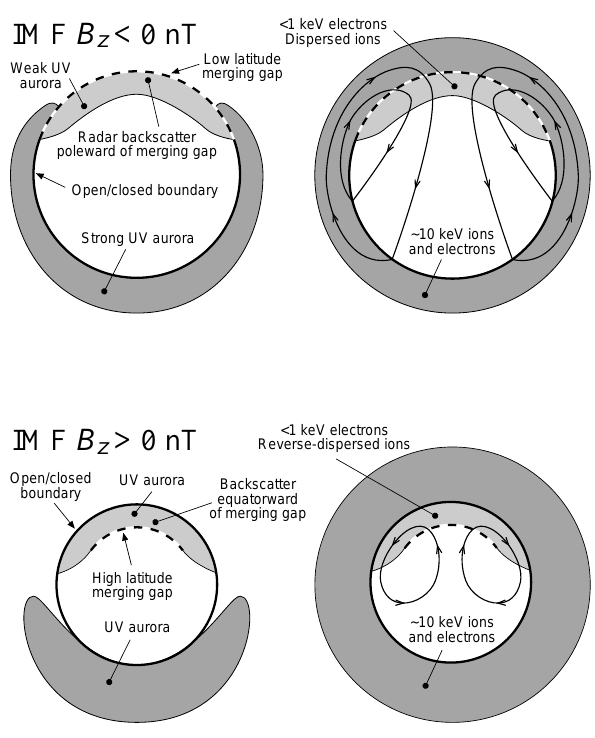
Fig. 5. A schematic diagram illustrating the main signatures em- ployed to identify the OCB (thick solid line) and their relationship to the dayside merging gap (thick broken line) and convection flow, for IMF northwards and southwards. Panels to the left indicate the UV and radar auroral regions. Precipitating particle characteristics and convection streamlines are shown to the